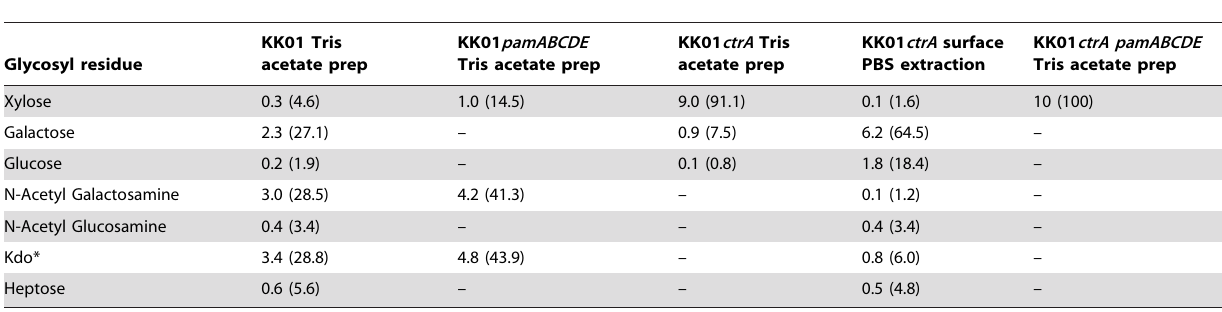
Table 2. Glycosyl composition of extracellular preparations of K. kingae strains used in this study.